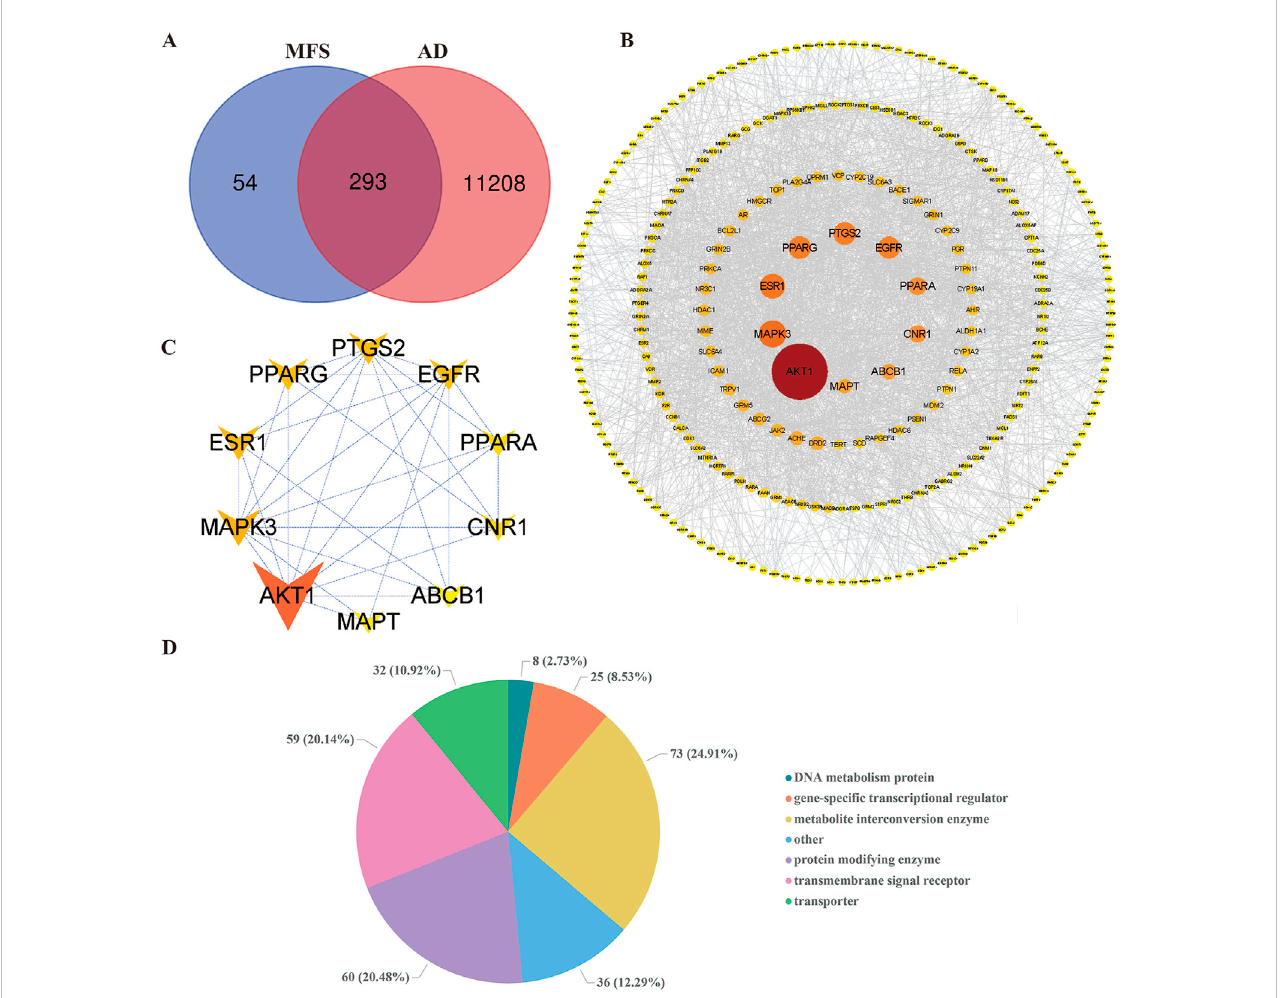
FIGURE 5 Alzheimer ’ s disease and miracle fruit-related targets and PPI network. The search obtained 11,501 AD-related targets, 347 MFS-related targets, and 293 disease – drug common targets. The top 10 core targets were screened by betweenness centrality. As the fi gure shows, the larger area of the circle could beconsideredasmoreimportantinthisnetwork. (A) Disease – drugtargetVenndiagram. (B) PPInetworkofdruganddiseasecommontargets. (C) Coretarget PPI network. (D) Pie chart of the top six molecular functions of MFS-AD common